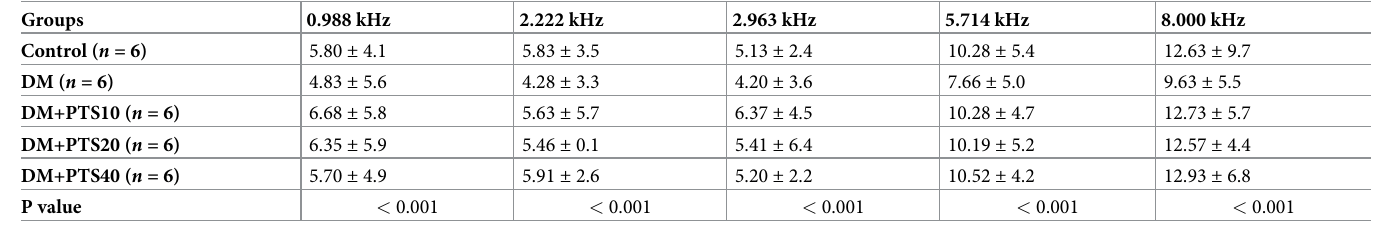
Table 1. The DPOAE amplitude (dB SPL) measurement results of the rat groups.